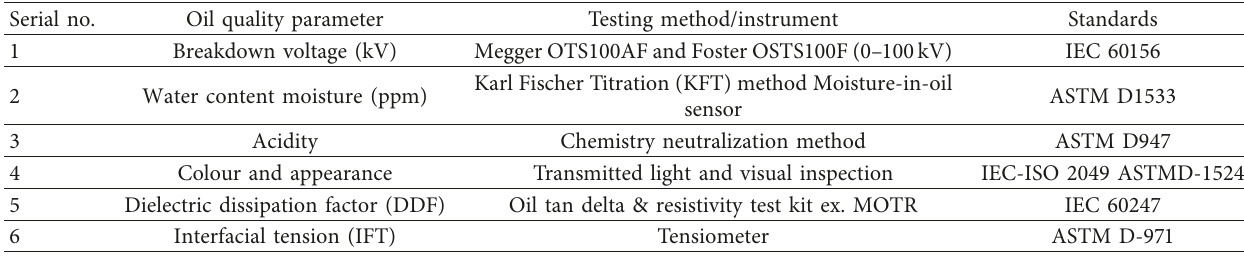
Table 1: Oil quality parameters.